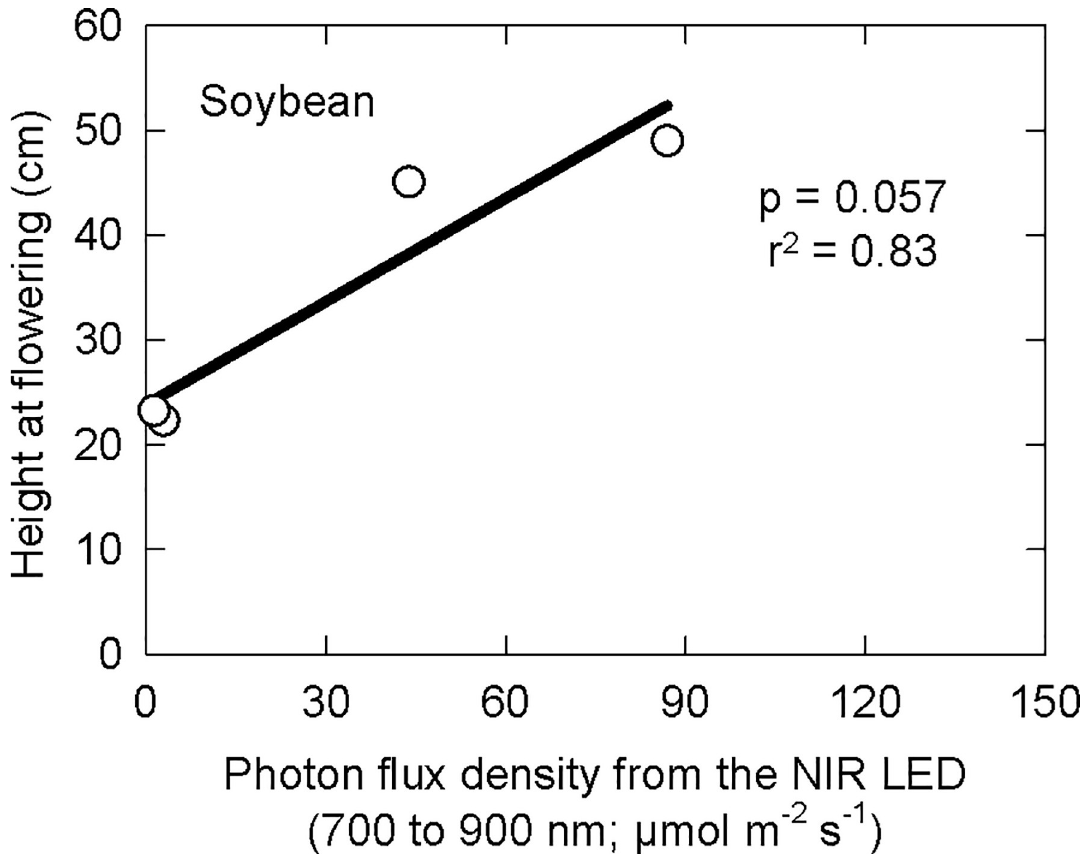
Fig 5. Effect of photons (between 700 and 900 nm) on soybean height at flowering. Data points are the average effect within each treatment. https://doi.org/10.1371/journal.pone.0255232.g005 PLOS ONE | https://doi.org/10.1371/journal.pone.0255232 July 27,